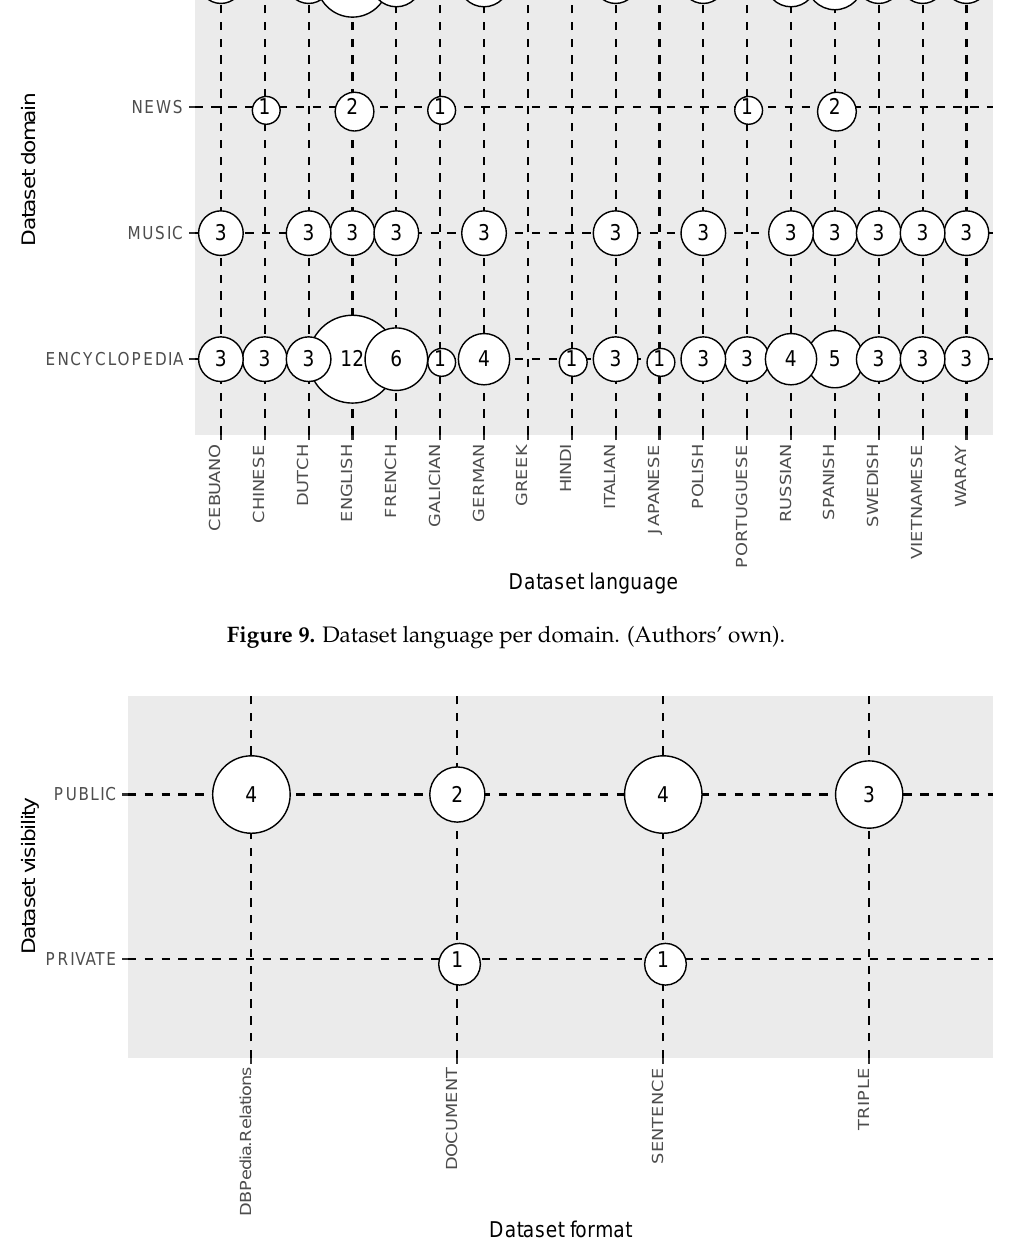
Figure 10. Mapping the dataset format and visibility from primary studies—for the x -axis, the format file of each dataset; for the y -axis, the visibility of the dataset. (Authors’